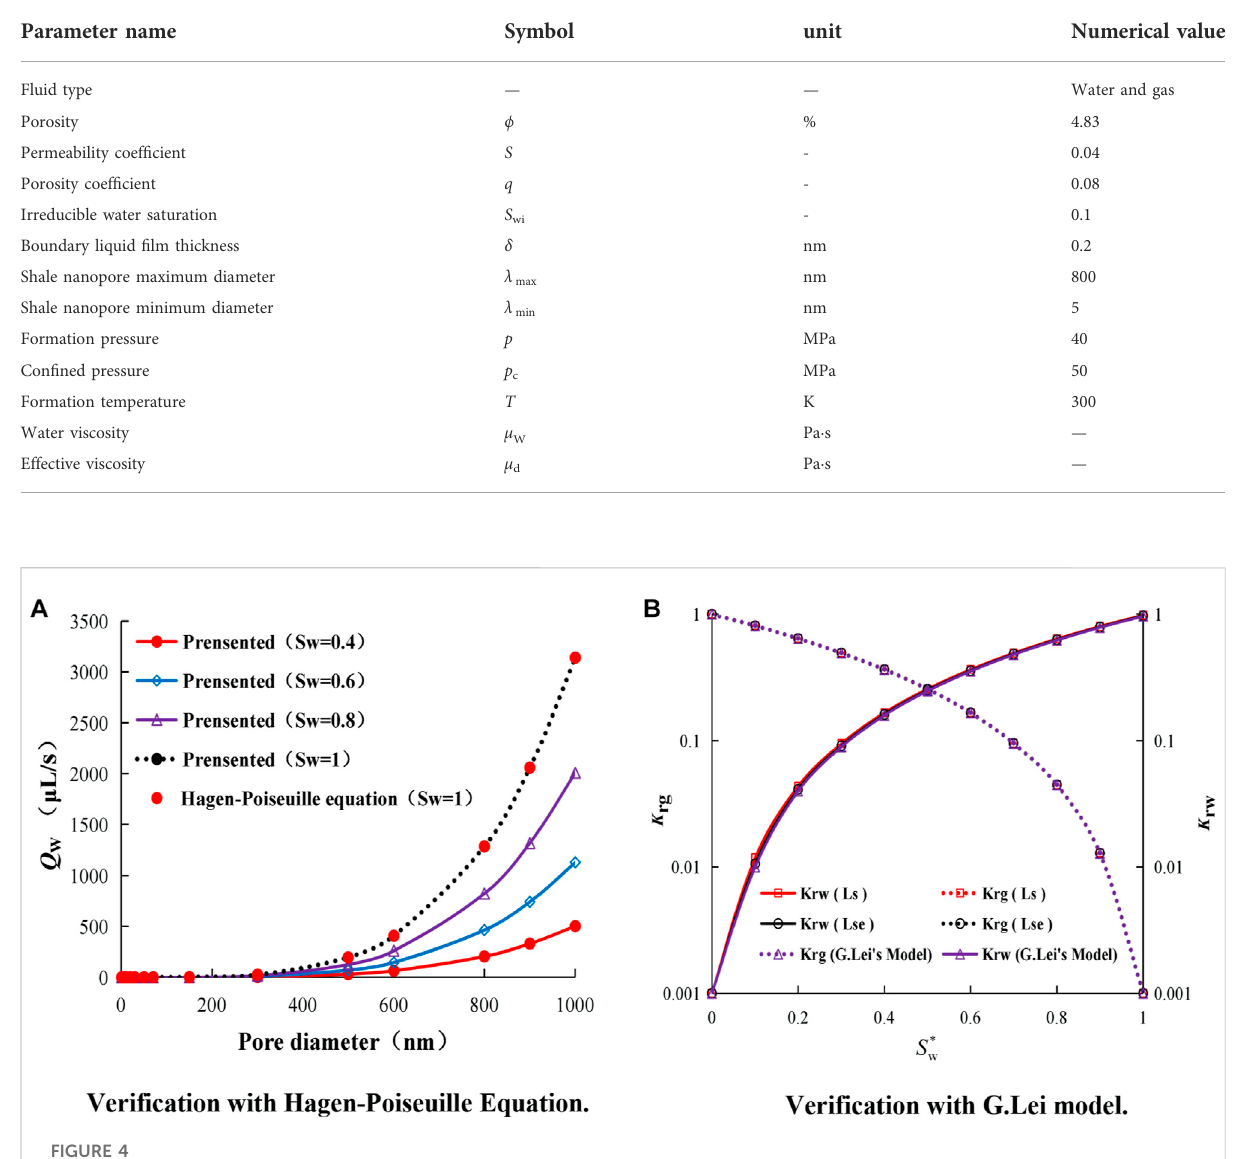
TABLE 1 Simulation basic data table.